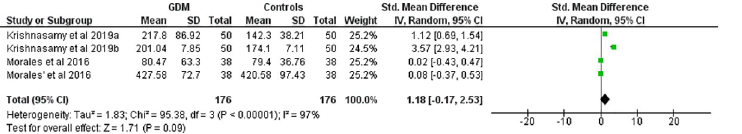
Fig 6. Forest plot depicting the level of ICAM-1 and VCAM-1 (ng/ml) among women with GDM and controls.